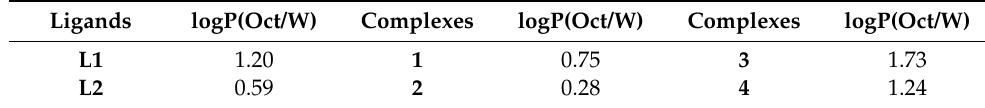
Table 3. logP values of complexes 1 – 4 at pH = 7.4.